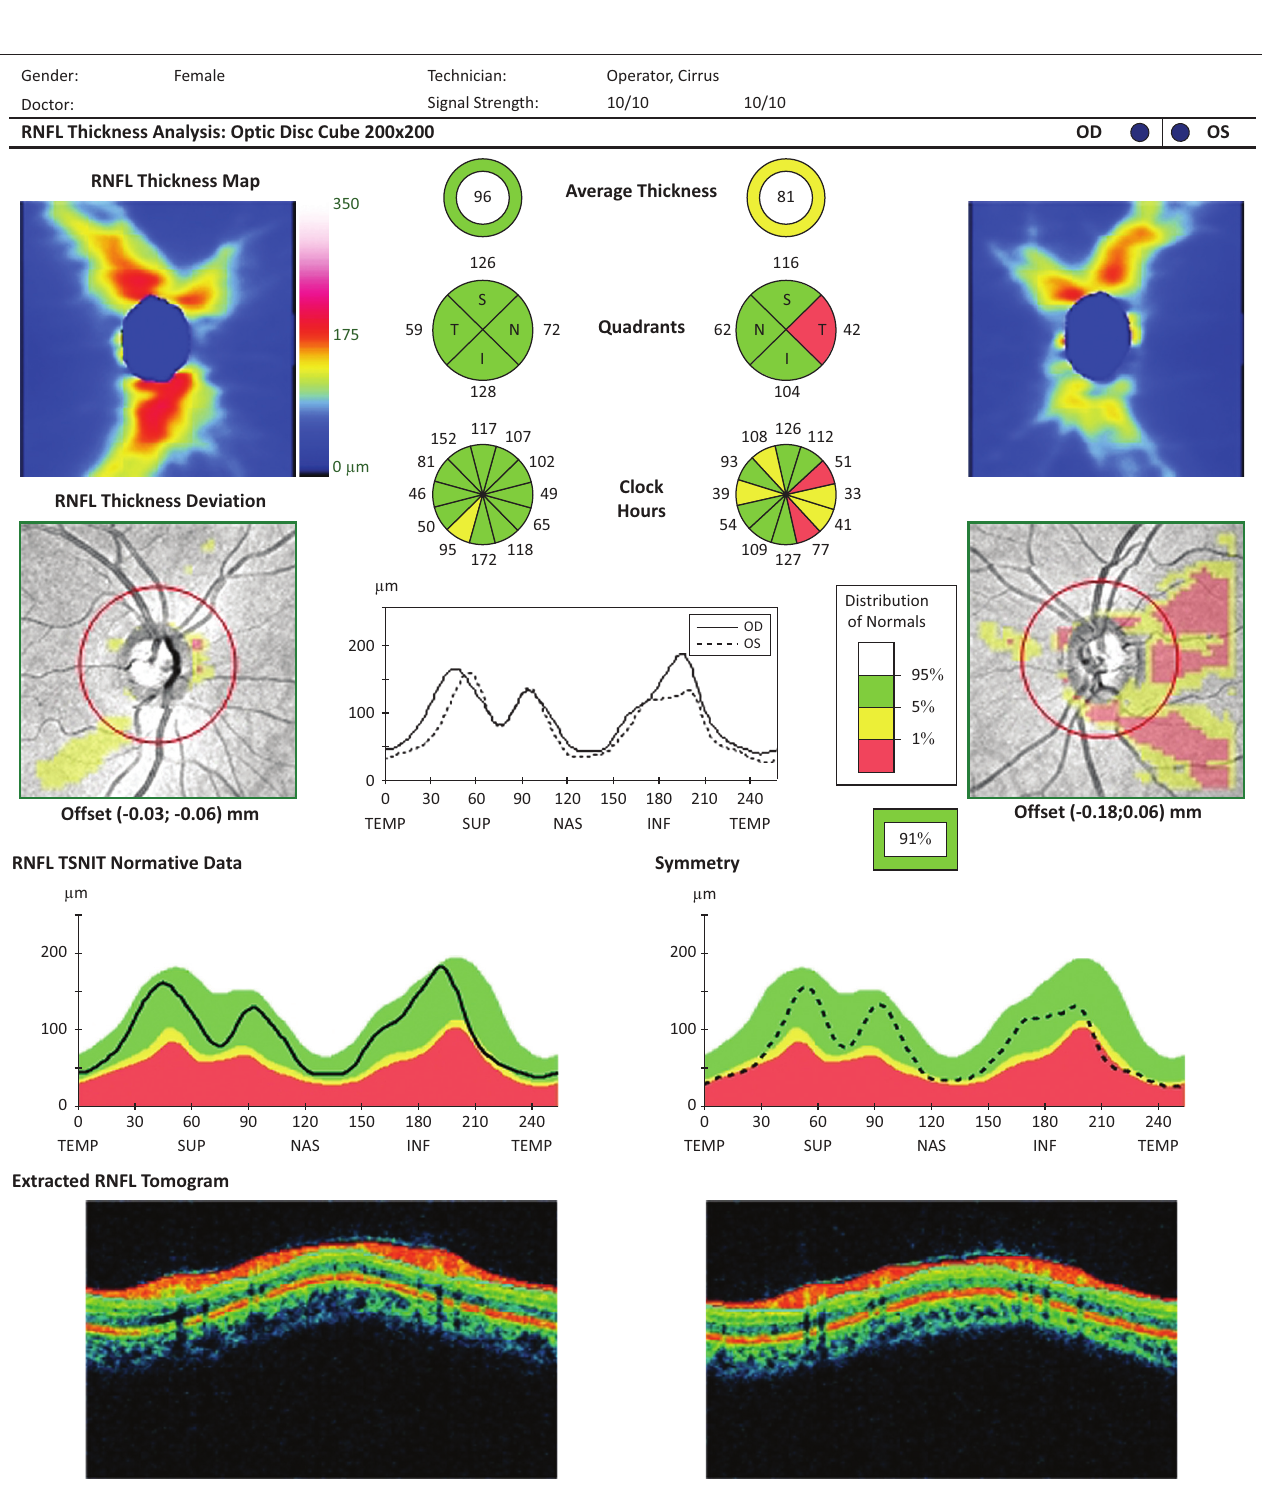
FIGURE 4: Optical coherence tomography findings in a patient with multiple sclerosis and no prior history of optic nerve. The average retinal nerve fibre layer thickness in the right eye (OD) is represented in green (indicating a value within normal range), while the average retinal nerve fibre layer thickness in the left eye (OS) is represented in yellow, indicating a reduced retinal nerve fibre layer thickness (yellow denotes values 1 % – 5 % of what would be expected when compared with a reference population). The temporal quadrant was the most severely affected, thereby contributing most to retinal nerve fibre layer thinning, as indicated by the representation in red, with all other quadrants being within normal